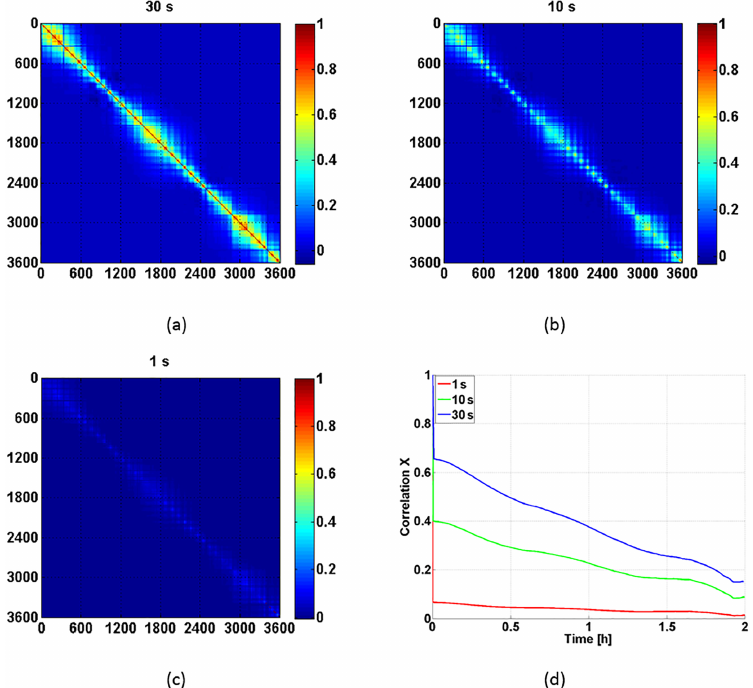
Figure 15. Correlation matrix for 30h time span in X -component obtained with a (a) 30s, (b) 10s and (c) 1s data rate. The identical epochs (30 s interval) are extracted from the respective correlation matrix. Panel (d) shows the mean correlation over 2h.